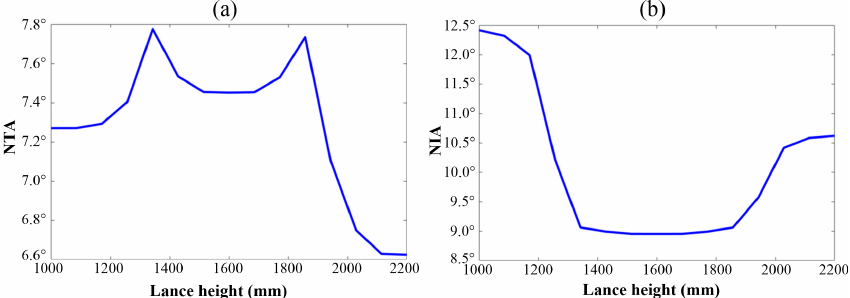
Figure 15. Inference curves based on the fuzzy control algorithm. ( a ) The optimal NTA variation with the lance height. ( b ) The optimal NIA variation with the lance